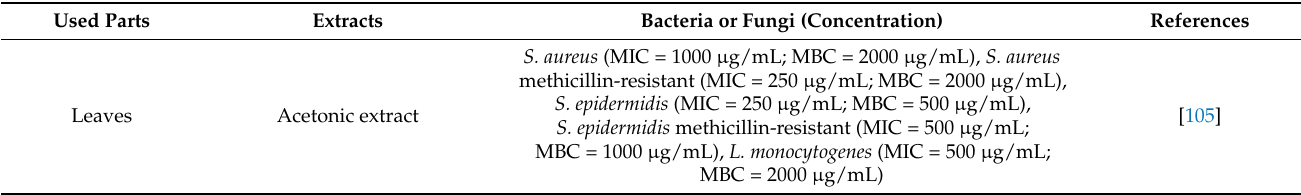
Table 3. The antimicrobial results of the Z. lotus extracts. Extracts Bacteria or Fungi